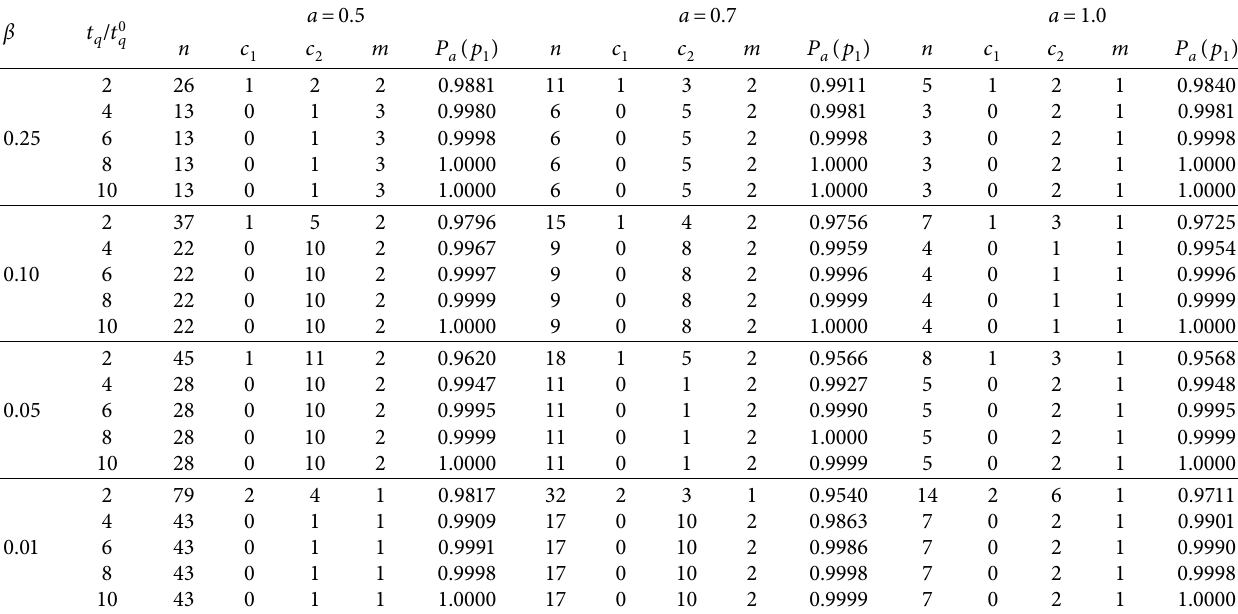
Table 4: Optimal parameters of the proposed MDSSP for EWD with δ � 1 . 5 , c � 2 at 50 th